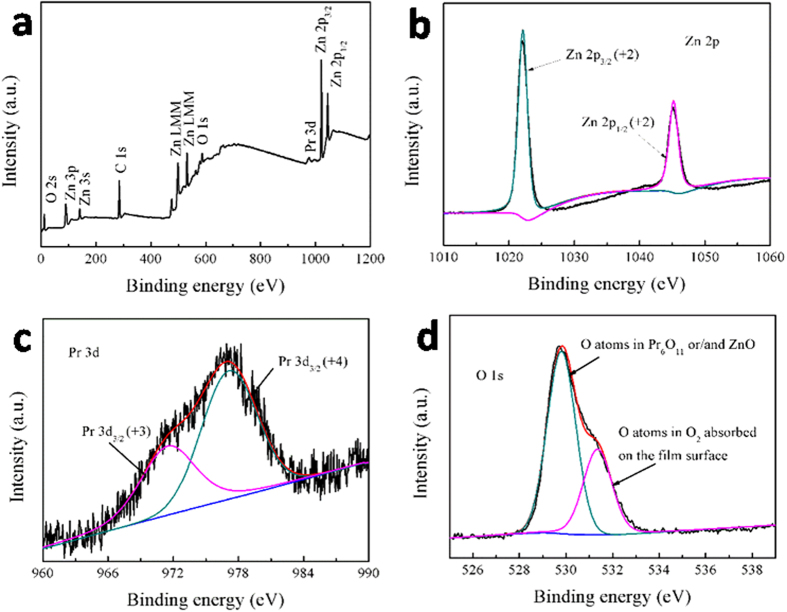
XPS results.(a) Full spectrum, and narrow spectra of, (b) Zn 2p, (c) Pr 3d and (d) O 1 s for typical hot-dipped sample (in Pr6O11 at 700 °C for 50 min in air).